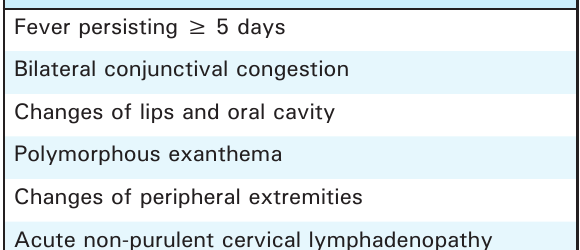
Table 1. Japanese criteria for diagnosis of Kawasaki